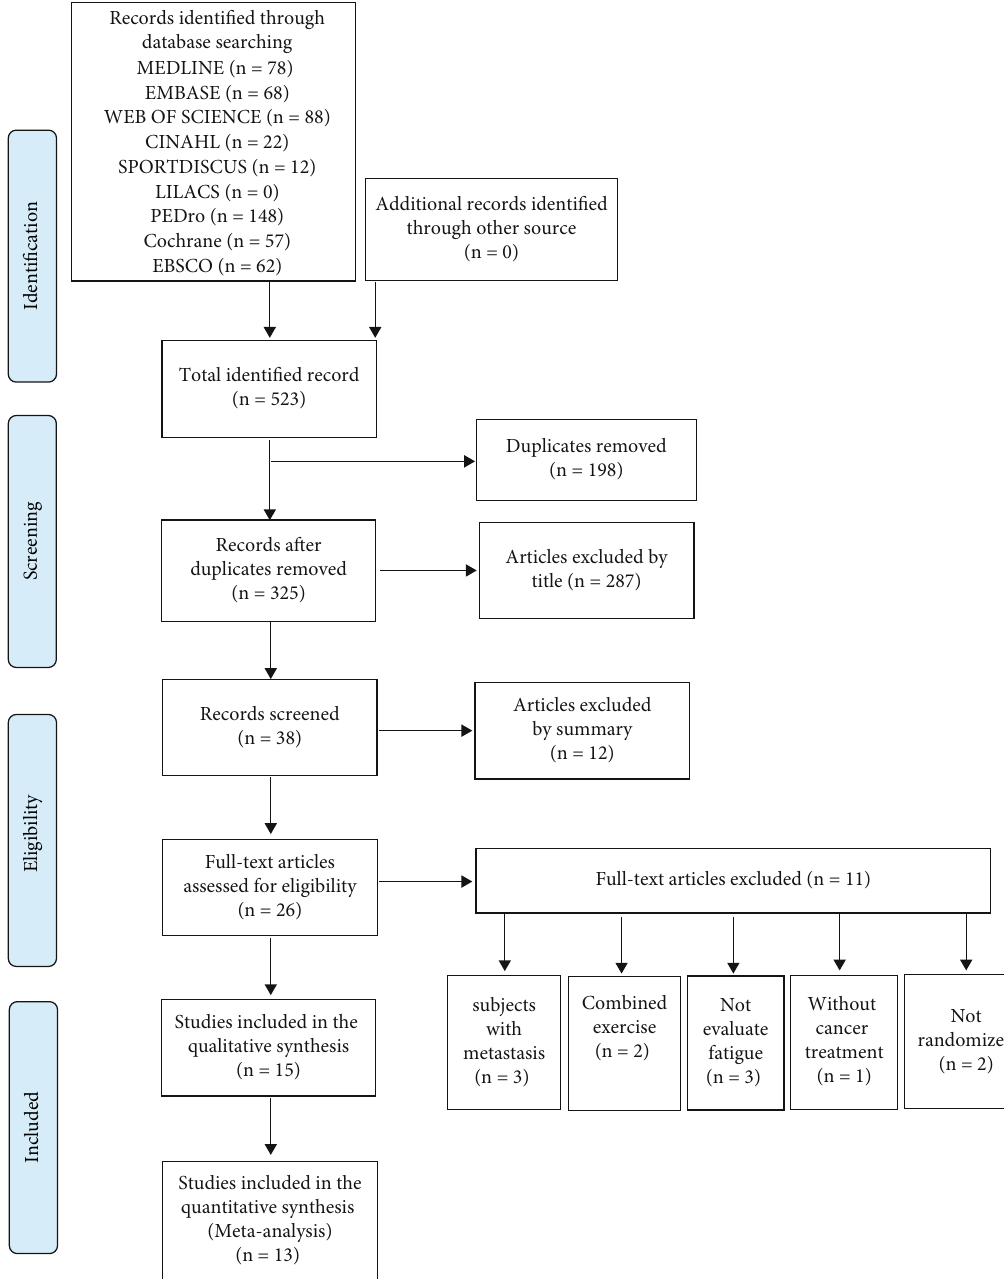
Figure 1: PRISMA fl ow diagram for the systematic